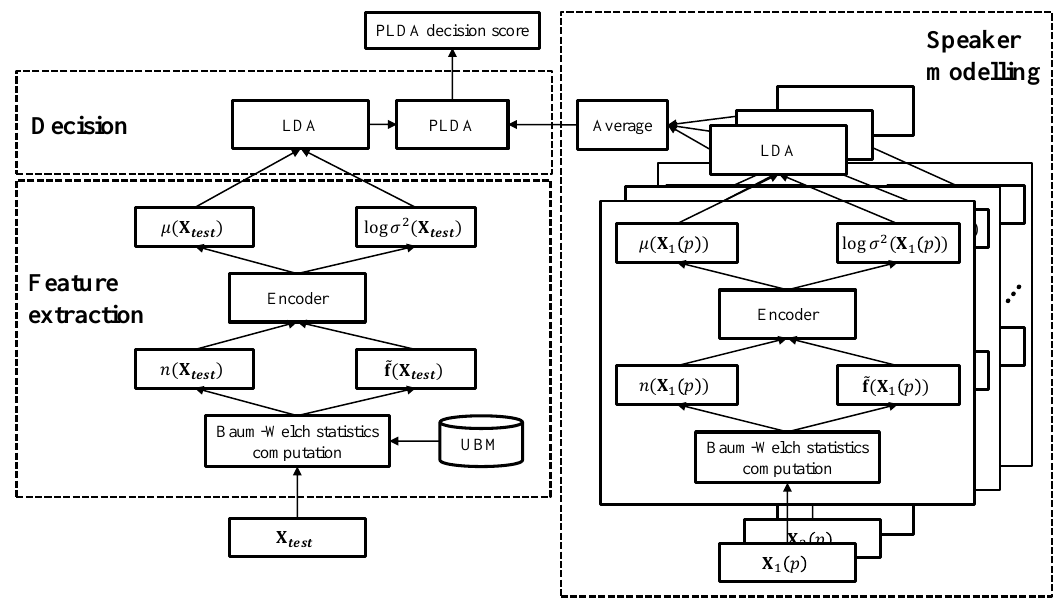
Figure 2. Flow chart of the speaker verification process using the proposed feature extraction